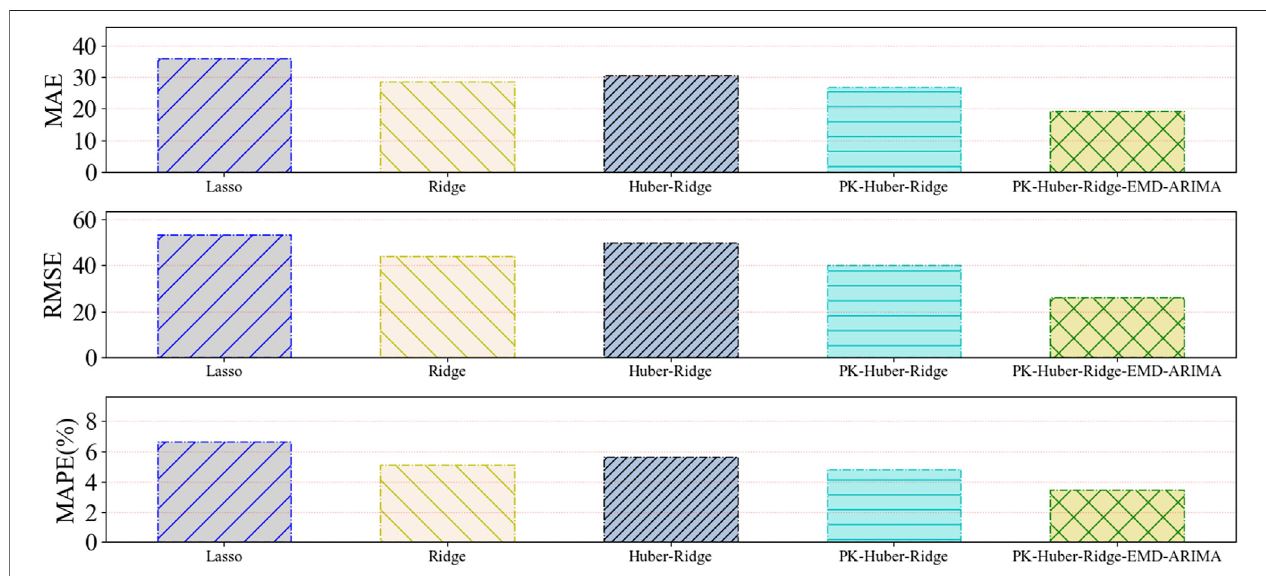
FIGURE 3 | A histogram of the predictive evaluation index values based on dataset 1 for fi ve types of forecasting models.